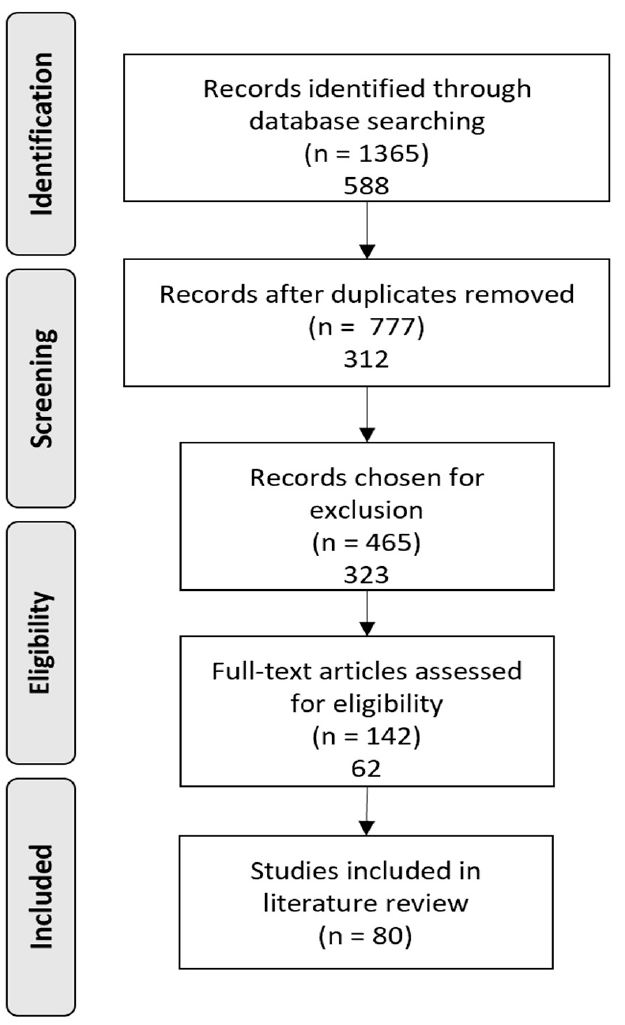
Figure 1. PRISMA Flow Diagram of Literature Search and Selection Process .